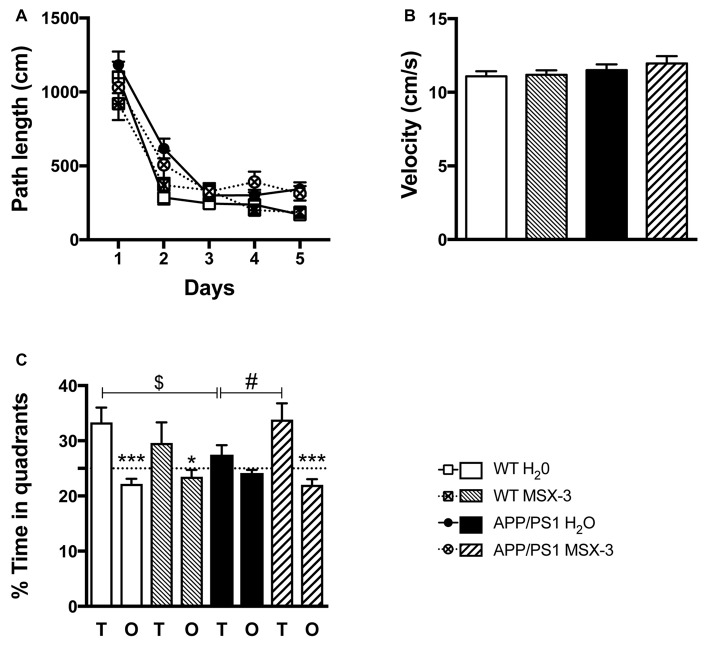
A2AR blockade prevents spatial memory impairments in APP/PS1 transgenic mice. Effect of MSX-3 treatment on spatial learning and memory using the Morris water-maze task. (A) Learning, as indicated by the equivalent path length needed to find the hidden platform (PF). At day 2, APP/PS1 mice exhibited a slight but significant higher path length as compared to WT animals (***p < 0.001 vs. WT H2O using One-way analysis of variance (ANOVA) followed by LSD Fisher post hoc test). (B) All genotypes exhibited a comparable velocity in the maze, suggesting no motor deficits. (C) Spatial memory was assessed 72 h after the last day of learning. Results represent the percentage of time spent in the target (T) vs. non-target (O) quadrants. WT mice (both treated with water or MSX-3) spent significantly more time in the T quadrant, indicative of a preserved spatial memory. While APP/PS1 mice exhibited spatial memory deficits as underlined by their lack of preference for the T quadrant, APP/PS1-MSX-3 treated mice behaved as WT mice, suggesting a rescue of memory impairment. *p < 0.05 ***p < 0.001 T vs. O; $p < 0.05 WT vs. APP/PS1; #p < 0.05 APP/PS1-H2O vs. APP/PS1 MSX-3 using One-way ANOVA followed by LSD Fisher post hoc test; N = 12–16 per group; Results are expressed as mean ± SEM.